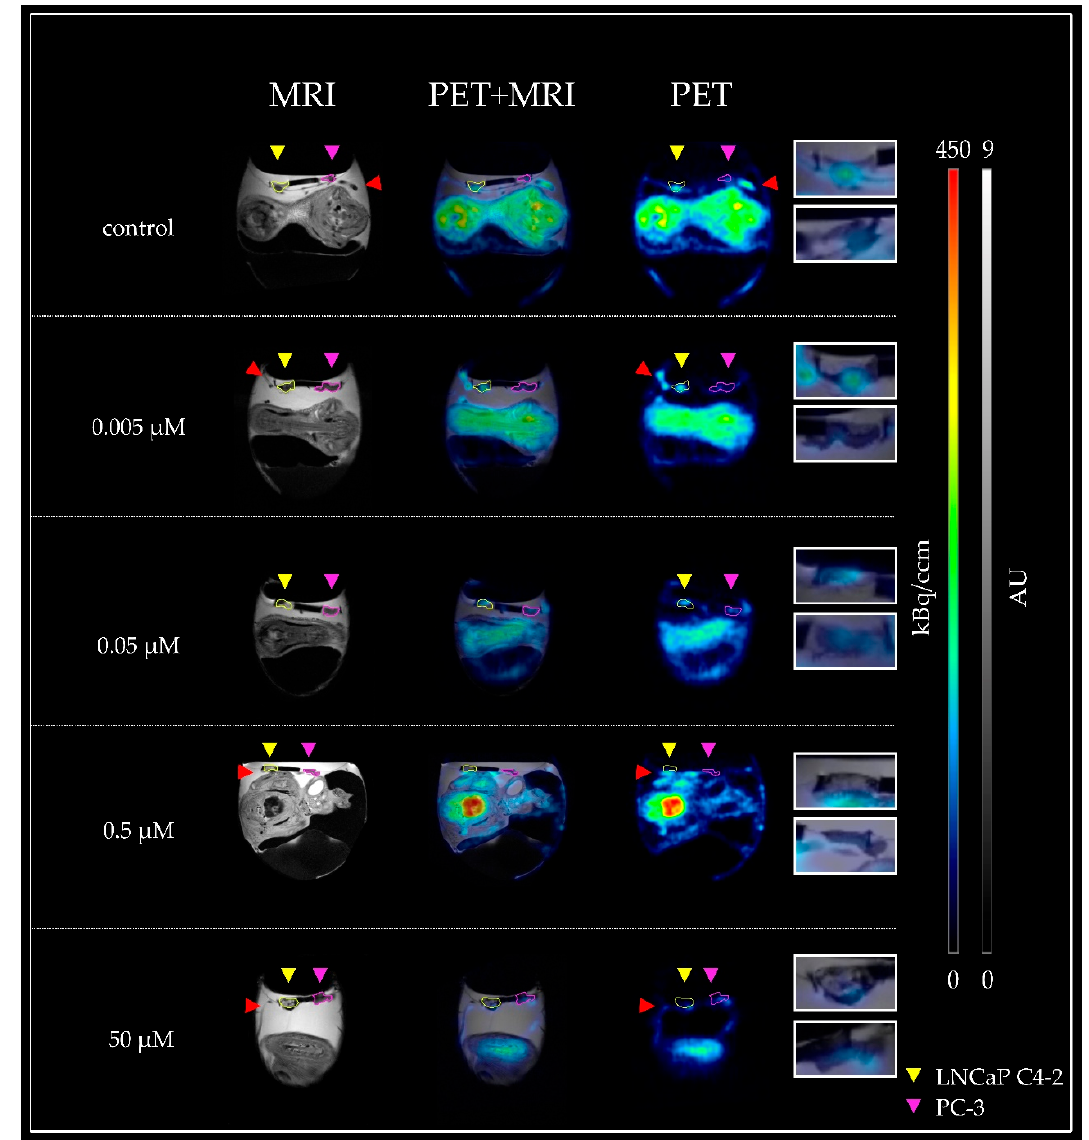
Figure 1. Representative MR and PET images of the CAM model injected with various inhibitor concentrations. From top to bottom, the applied inhibitor concentration was increased. Tumor regions were obtained by a T2-weighted RARE scan ( left ), while a static reconstruction of a 60 min PET scan was used to demonstrate the accumulation of the radioligand ( right ). In the resulting fusion image (middle), a marked accumulation of [ 18 F]siPSMA-14 could be localized in the PSMA − positive tumor LNCaP C4-2 (yellow arrow, left tumor) for the control and the lowest inhibitor concentration (0.005 µM). While [ 18 F]siPSMA-14 accumulation in LNCaP C4-2 tumors decreased with increasing inhibitor concentration, [ 18 F]siPSMA-14 accumulation in PC-3 (magenta arrow, right tumor) remained approximately the same for all concentrations. For better visualization, the tumor xenografts were delineated in color. Magnified images of the corresponding tumor regions are depicted on the right in separate boxes (LNCaP C4-2 upper box, PC-3 lower box). The signal in the blood vessels (red arrows) must be carefully distinguished from accumulation in the tumor.